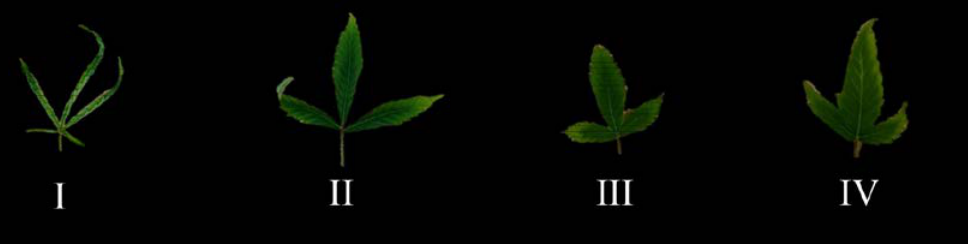
Figure 6. Effect of the number of subcultures (i.e., I, II, III, and IV) on leaf anatomy of in vitro grown cannabis.